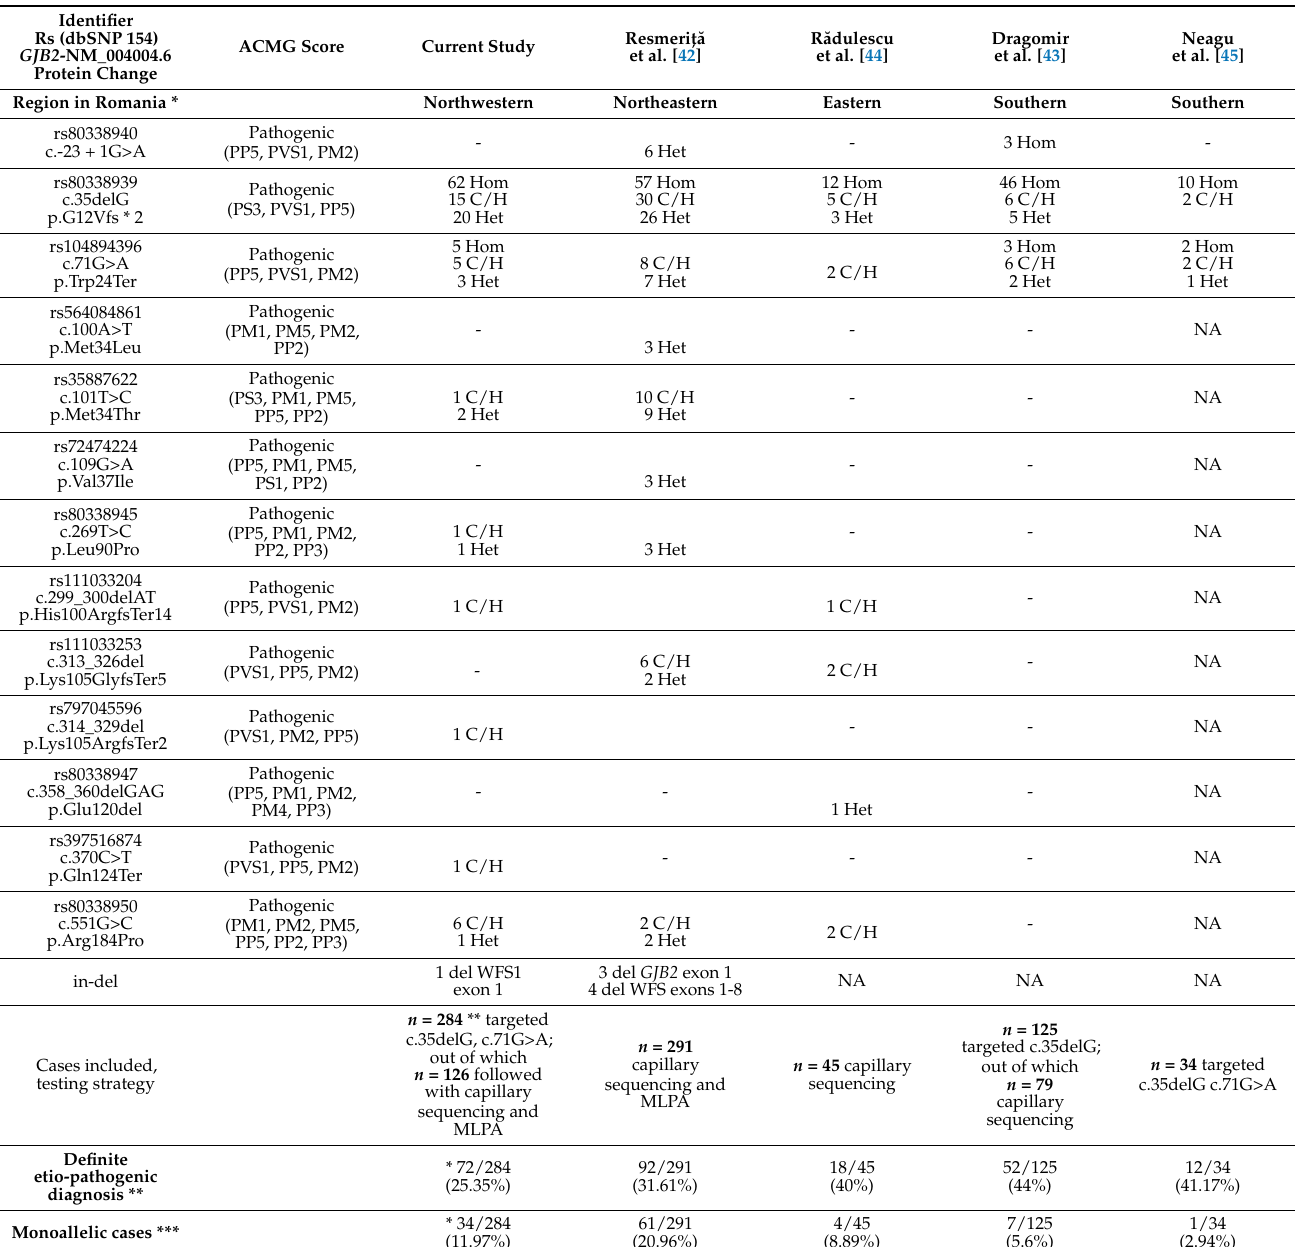
Table 4. Pathogenic or likely pathogenic variants described in our cohort as well as other Romanian cohorts published to date. Deafness variation database was consulted and pathogenicity calls coincided, where